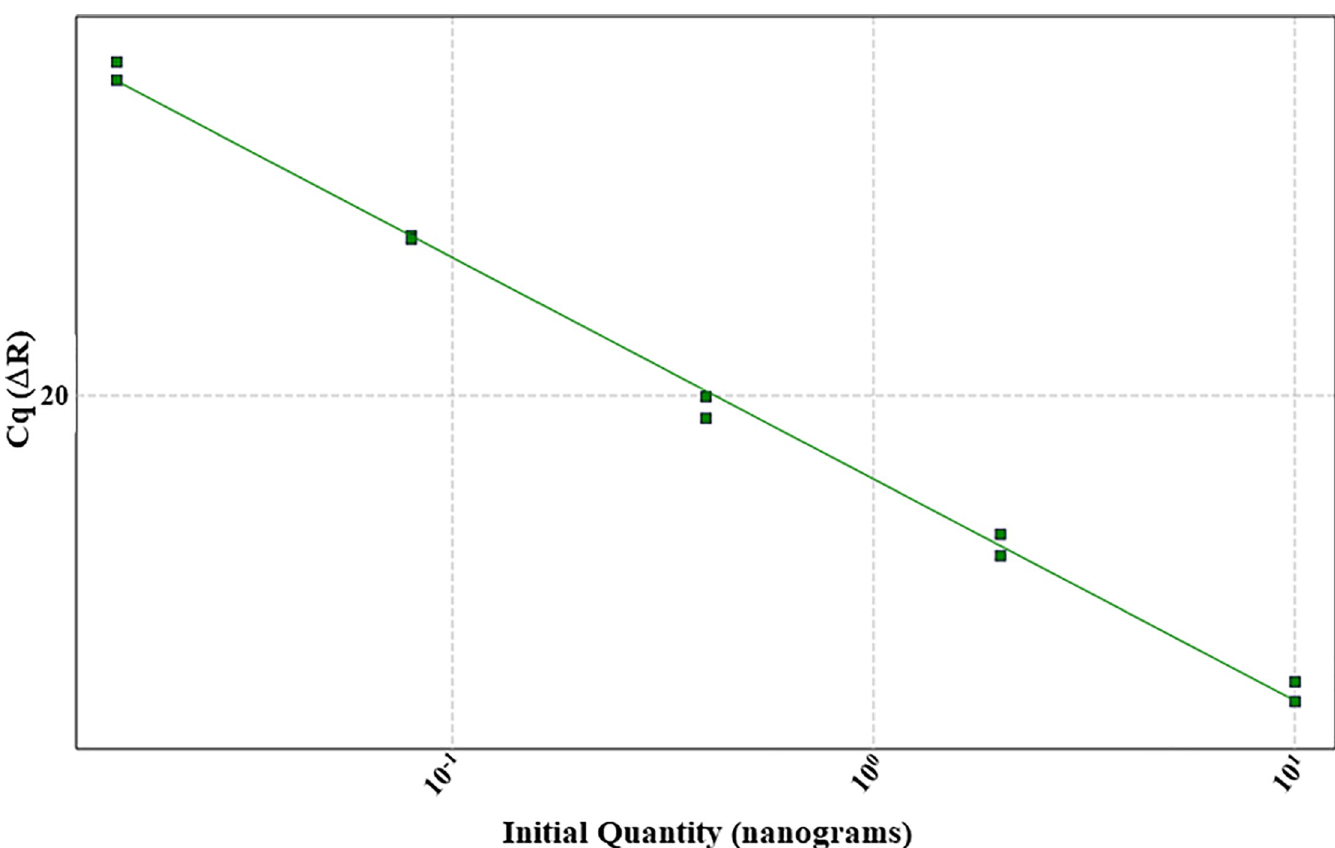
Fig 2. Exemplary standard curve diagram for CLDN10. The graph shows three independent serial dilutions forming linear standard curves in a singleplex RT-qPCR for CLDN10.